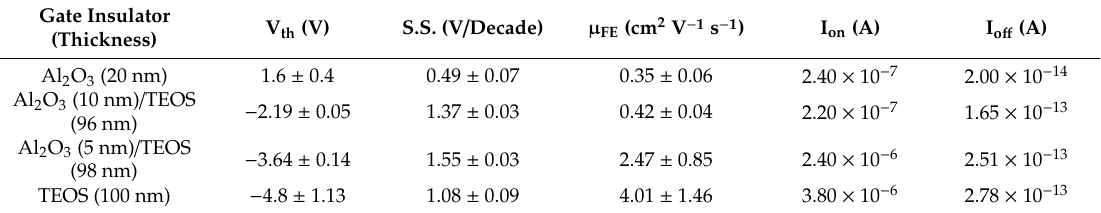
Figure 2. Representative transfer characteristics of a-IGZO TFTs at W / L = 100 / 5 µ m with four kinds of gate dielectrics. Table 1. The extracted electrical parameters of a-IGZO TFTs at V DS = 0.1 V and W / L = 100 / 5 µ m with four kinds of gate dielectrics. S.S.: subthreshold